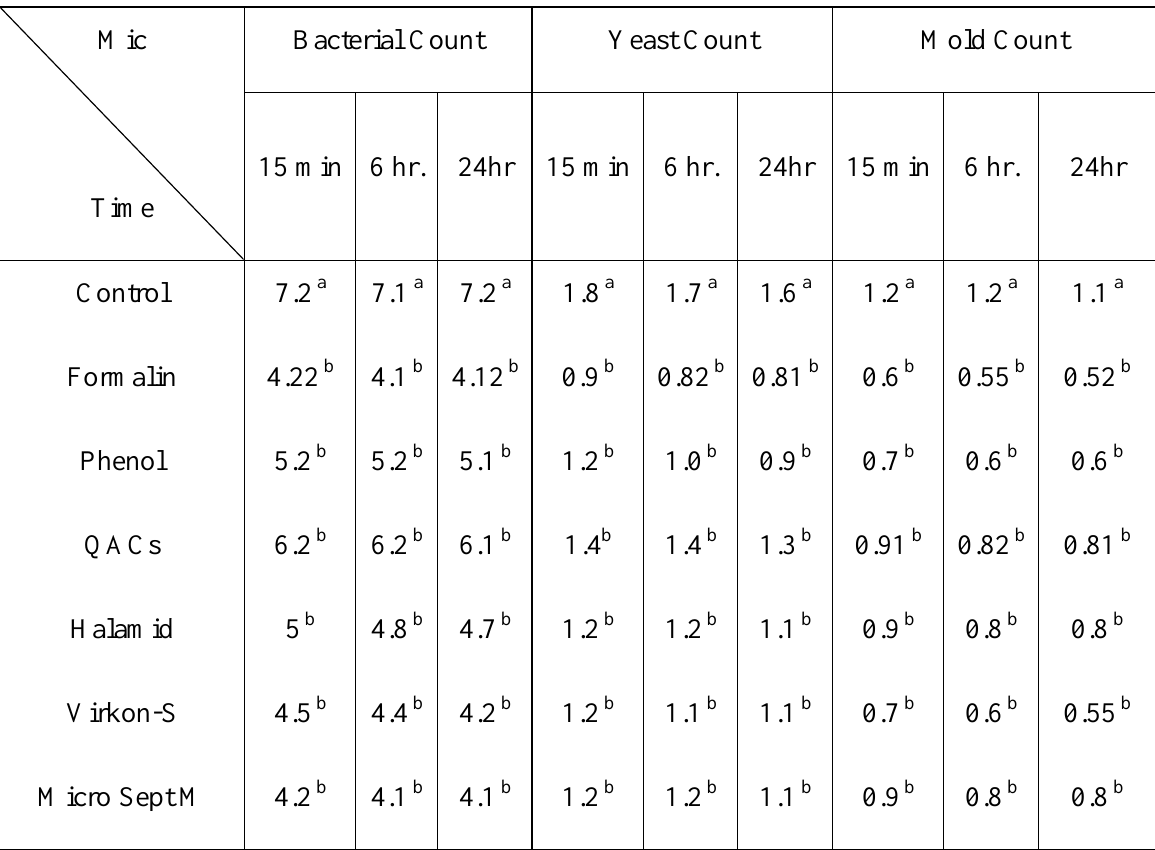
15 min 6 hr. 24hr Time